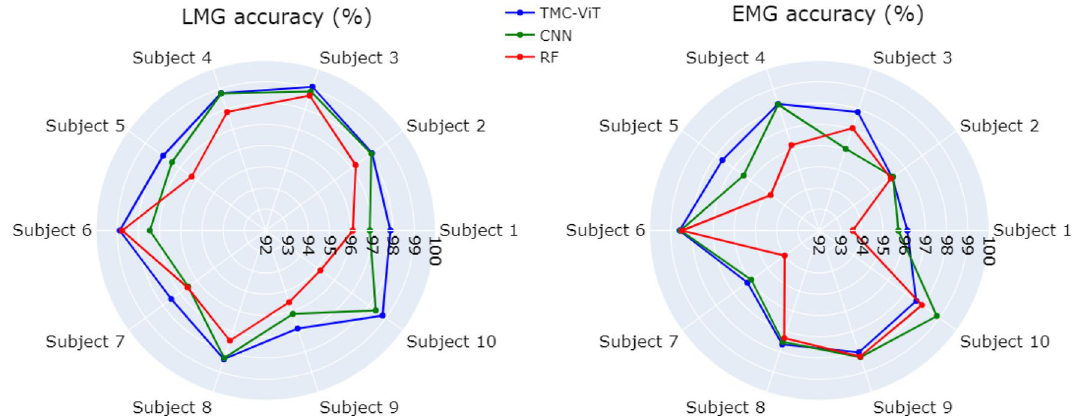
Figure 6. Decoding accuracy, in percentage, achieved by the TMC-ViT, CNN, and RF models. The accuracy achieved by the LMG-based models is shown on the left, and the EMG-based models are shown on the